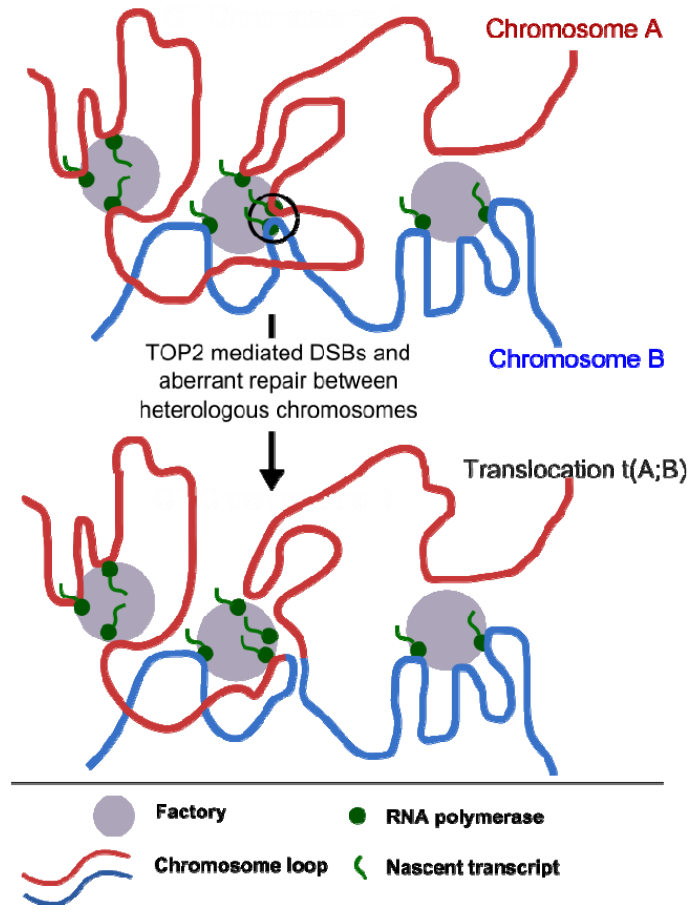
Figure 5. Clustering of transcription into transcription factories could facilitate chromosome translocation. Segments of two juxtaposed chromosomes are shown in red and